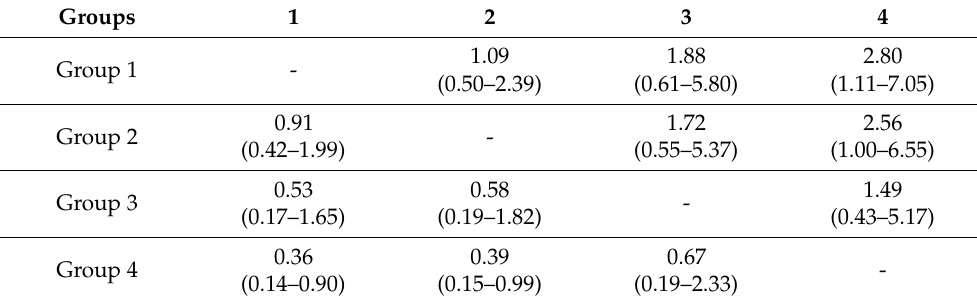
Table 5. Hazard ratios (HR) with a 95% confidence